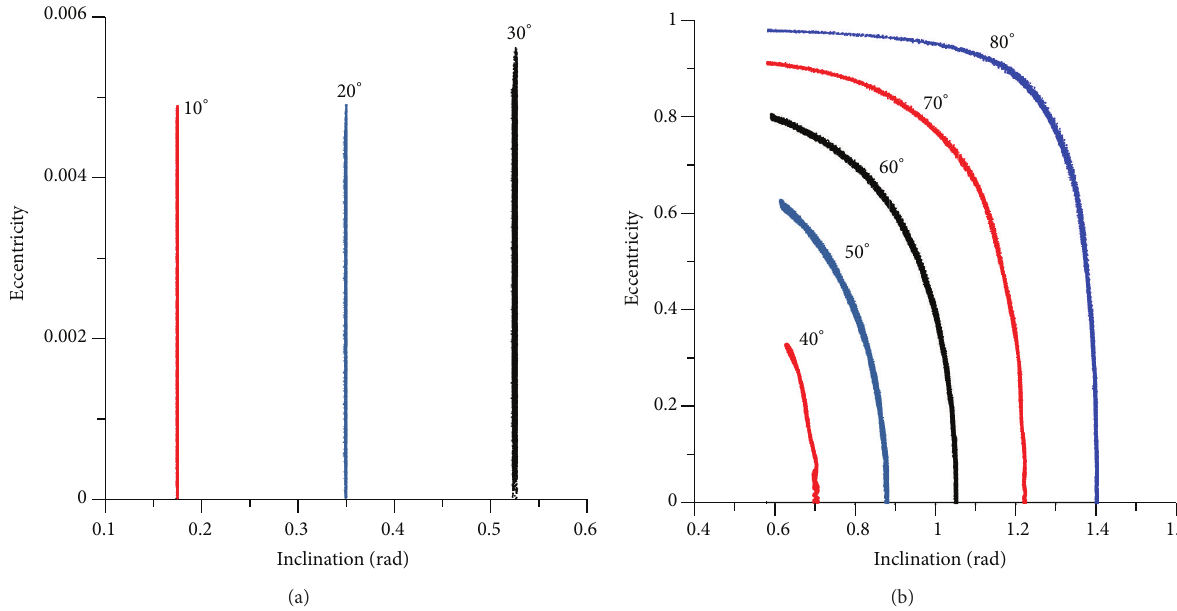
Figure 8: Plots of inclination versus eccentricity for circular and direct orbits (exact model). The initial conditions are a = 0.341 canonical units, e (0) = 0, M 0 (0) = 0, 𝜔 (0) = 0, and Ω (0) = 0.